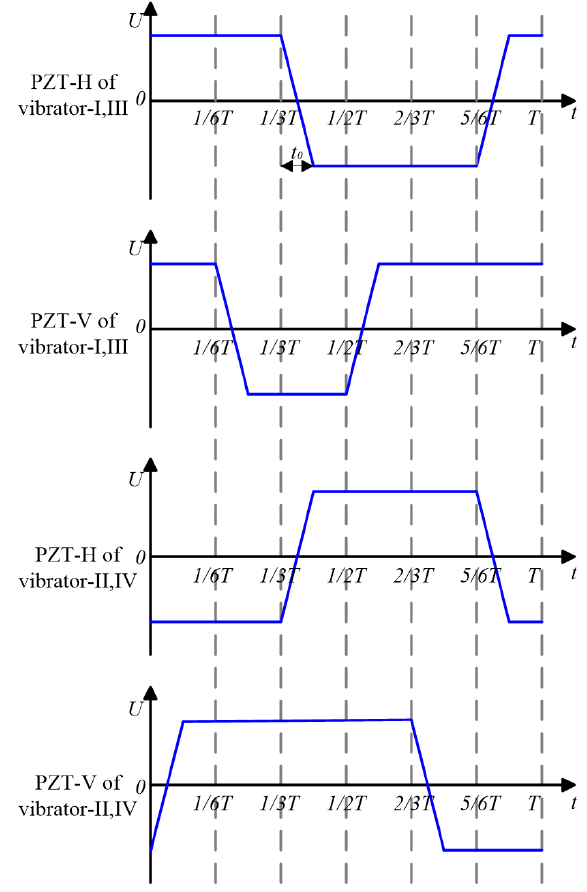
Figure 3. The driving signals applied on the proposed actuator.